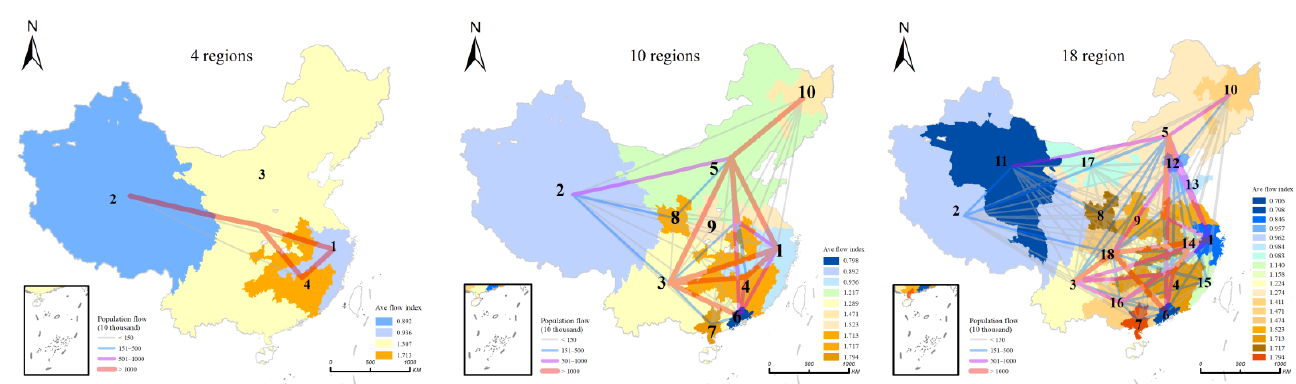
Figure 6. The “source -flow- sink” system of population flow during Spring Festival Transport in 2019 in China.